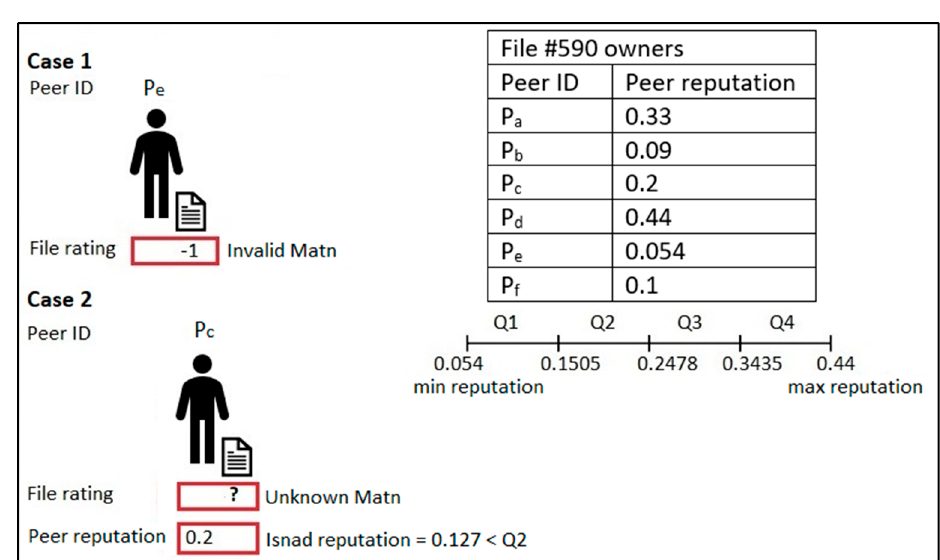
Figure 6. Weak Isnad.